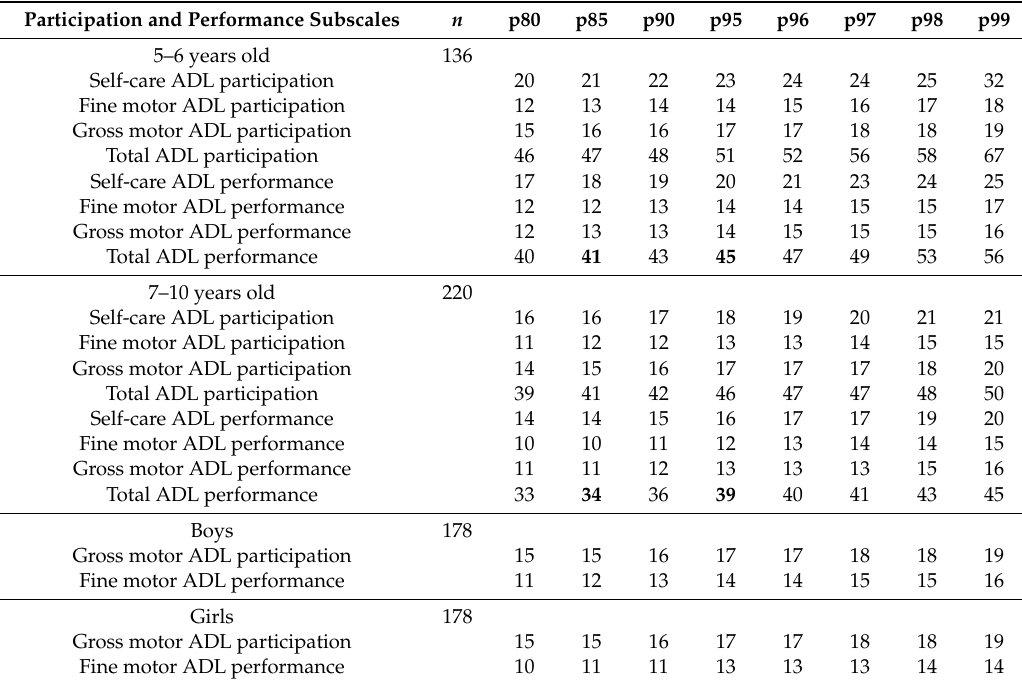
Table 4. Percentiles for participation and performance subscales and total scores across age groups and sex ( n =